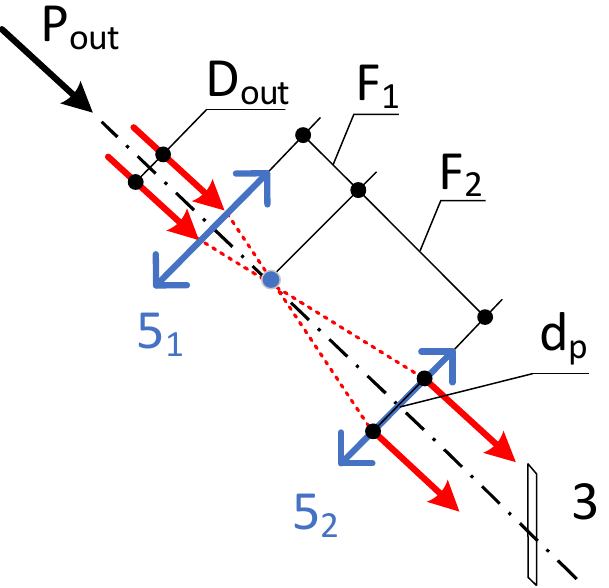
Figure 3. Beam expansion in the block of light source. Here, 3 is the window through which the beam enters the seed pipe. F1 is the focal length of the lens 5 1 , F2 is the focal length of the lens 5 2 in Figure 2, P out , D out and d p are output power of the light source, diameter of the radiation beam at the output of the light source, and diameter of the beam before entering the seed pipe, respectively.